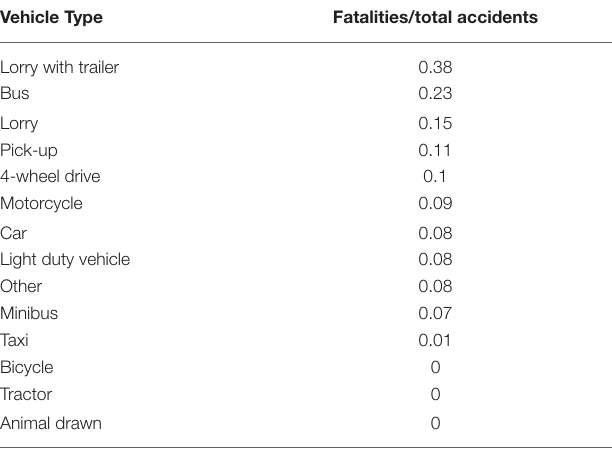
TABLE 4 | Fatalities as a ratio of total number of pedestrian accidents by vehicle type. Vehicle Type